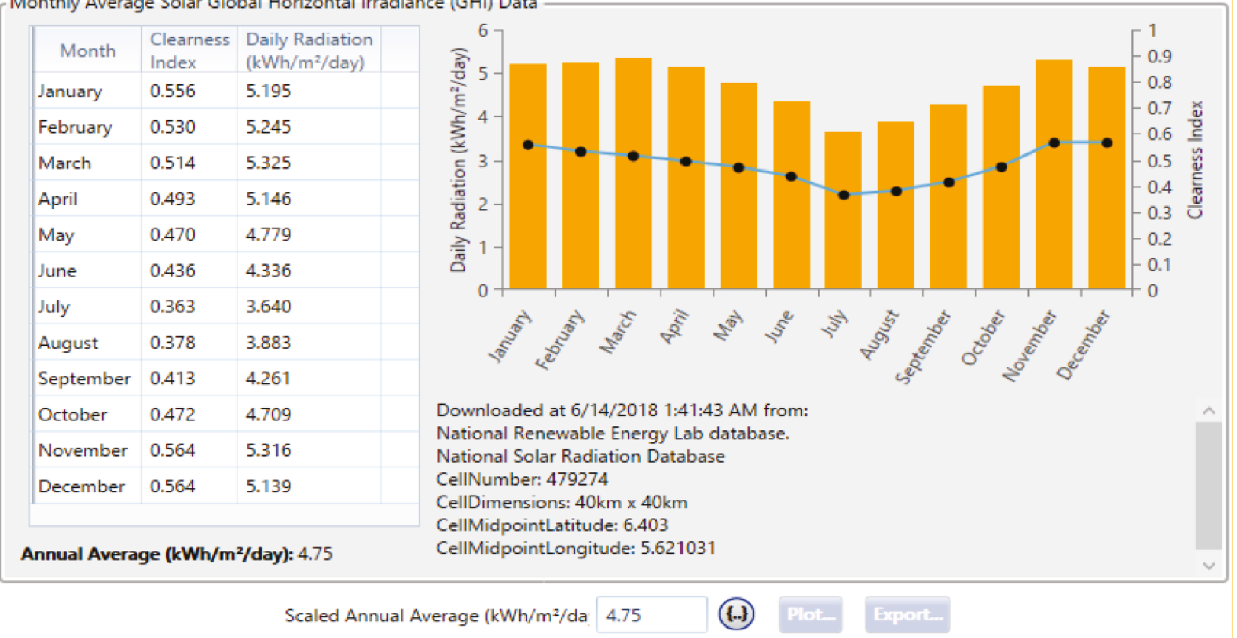
Figure 5: Downloaded solar irradiance of the house